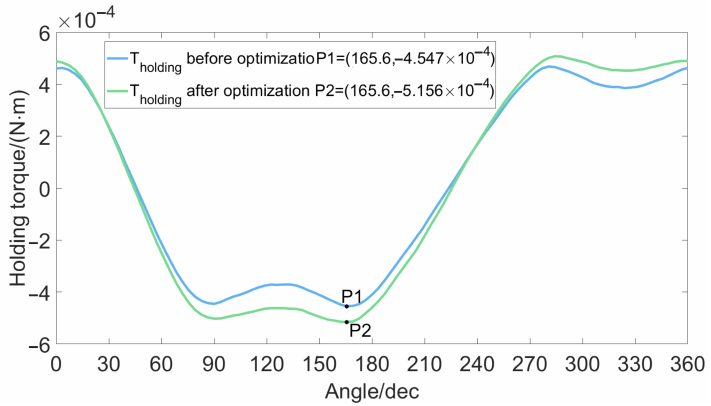
Figure 7. Comparison of holding torque.